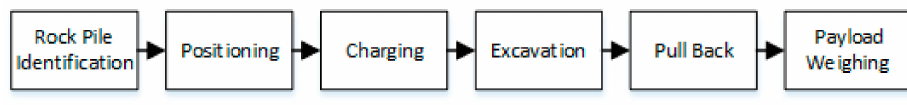
Figure 2. Steps of the proposed autonomous loading